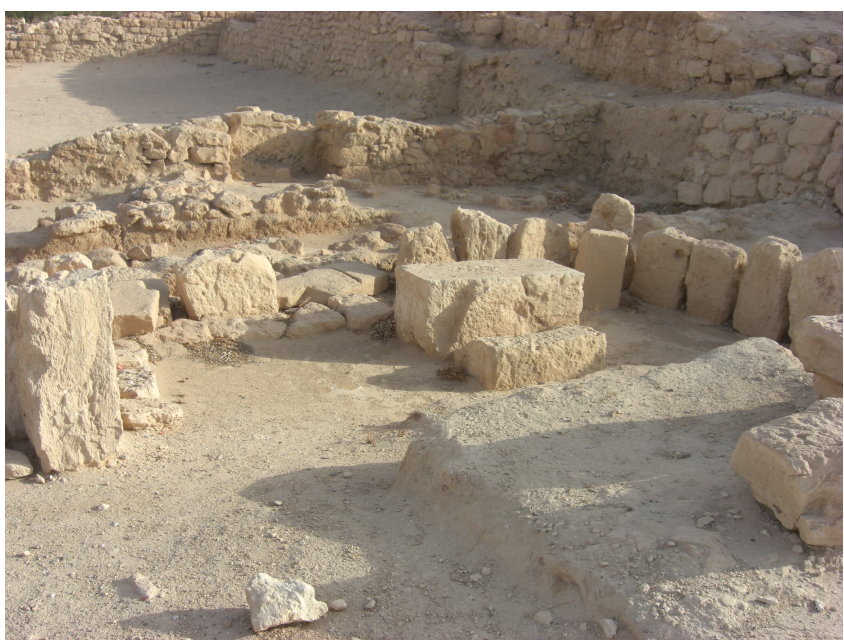
Figure 12 Reconstruction of the ‘En Hazeva shrine: view from the northwest. Photo by the author. associated with the worship of these deities, although they are of post-Babylonian period date (Hausleiter 2012,